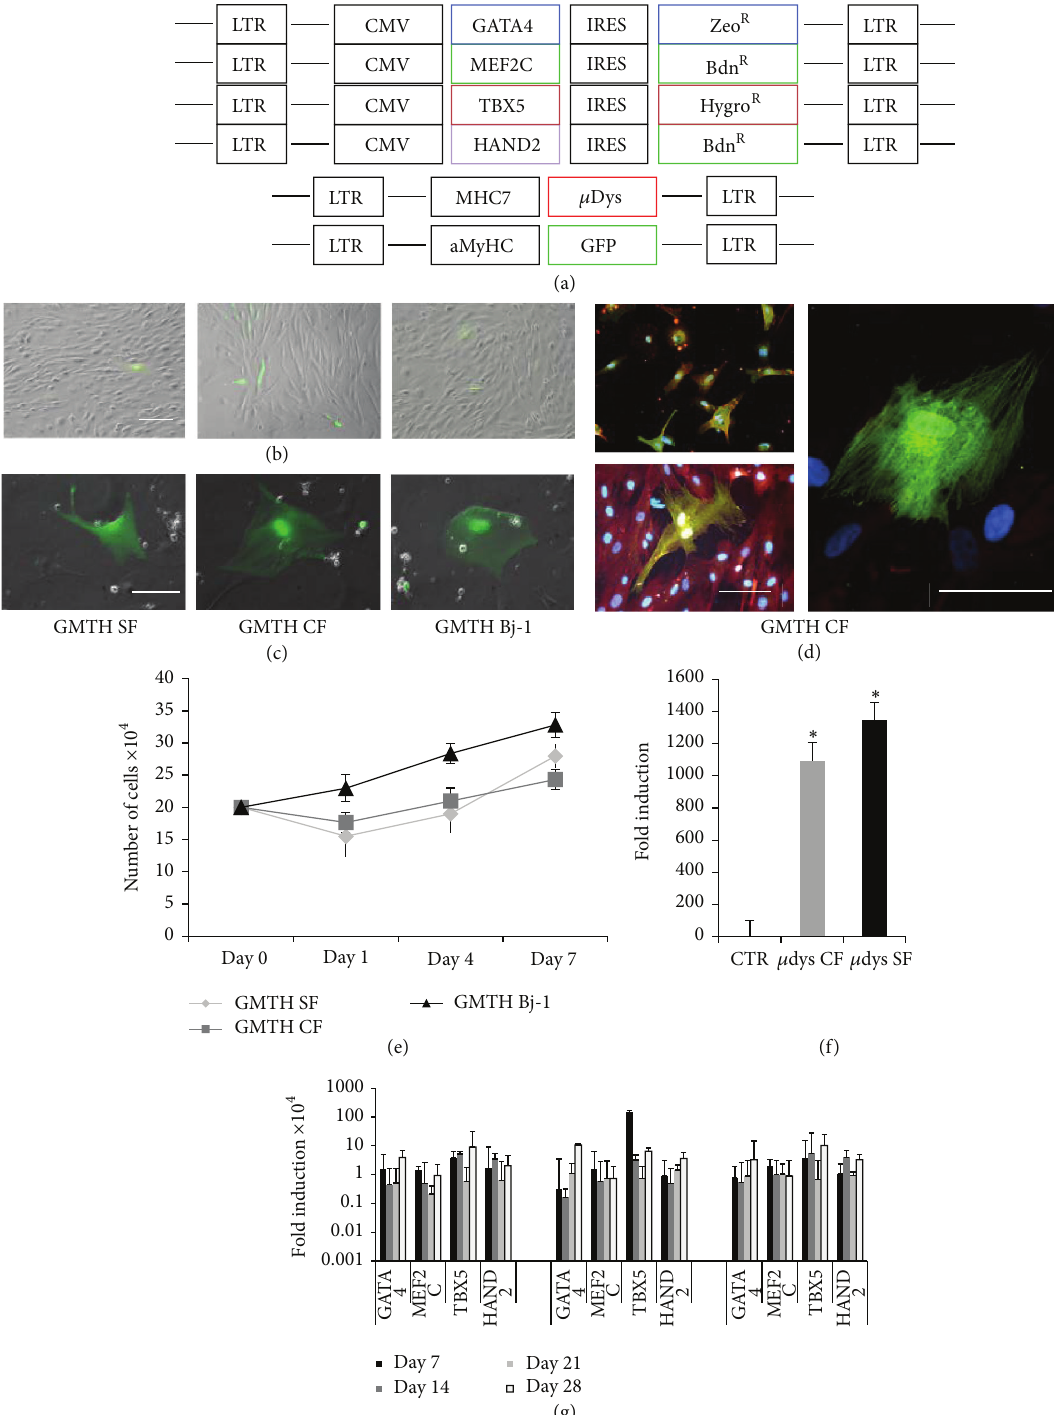
Figure 2: Viral transduction and exogenous gene expressions. (a) Schematic representation of the lentiviral vectors carrying the human sequence of the transcription factor genes (GATA4-MEF2C-TBX5-HAND2), the microdystrophin gene, and the GFP reporter gene. (b) The GFP reporter gene under the control of the 𝛼 -MyHC promoter was already expressed 48 hours after transduction. (c) Fibroblasts underwent morphology changes 7 days after transduction and become flattened and binucleated cells expressing GFP. (d) Immunofluorescence analysis on GHMT CF alone (top left panel) and in coculture with neonatal rat cardiomyocytes (bottom left panel), with antibodies against GFP (green) and myosin heavy chain (red), shows double positive cells and single positive cells for GFP (right panel). (e) Cell growth curve after transduction shows a decrease of cell proliferation ( 𝑛 = 5 /cell type). (f) Fold induction of microdystrophin ( 𝜇 dys) mRNA expression in transduced cells compared to the control; 𝑛 = 5 ∗ 𝑝 < 0.01 , CF and SF versus controls (CF and SF transduced with empty vector). (g) Exogenous transcription factors expression ( 𝑛 = 5 ) after transduction shows high induction levels during the 28 days of